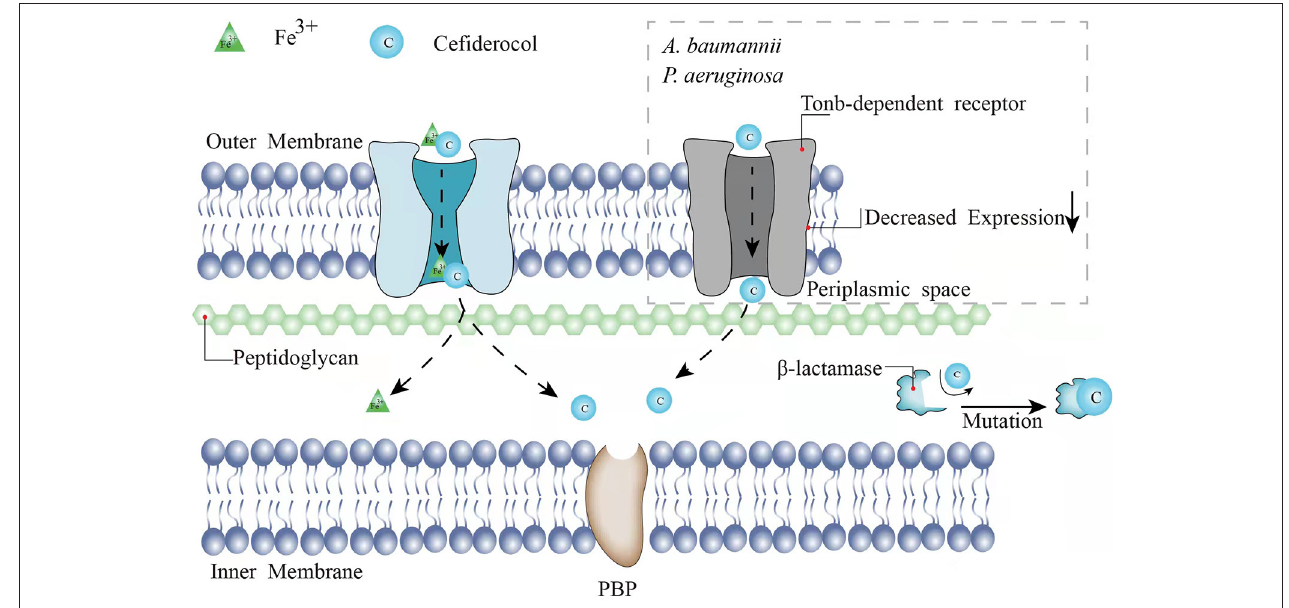
FIGURE 1 | The mechanisms and underlying resistance mechanisms of CFDC.